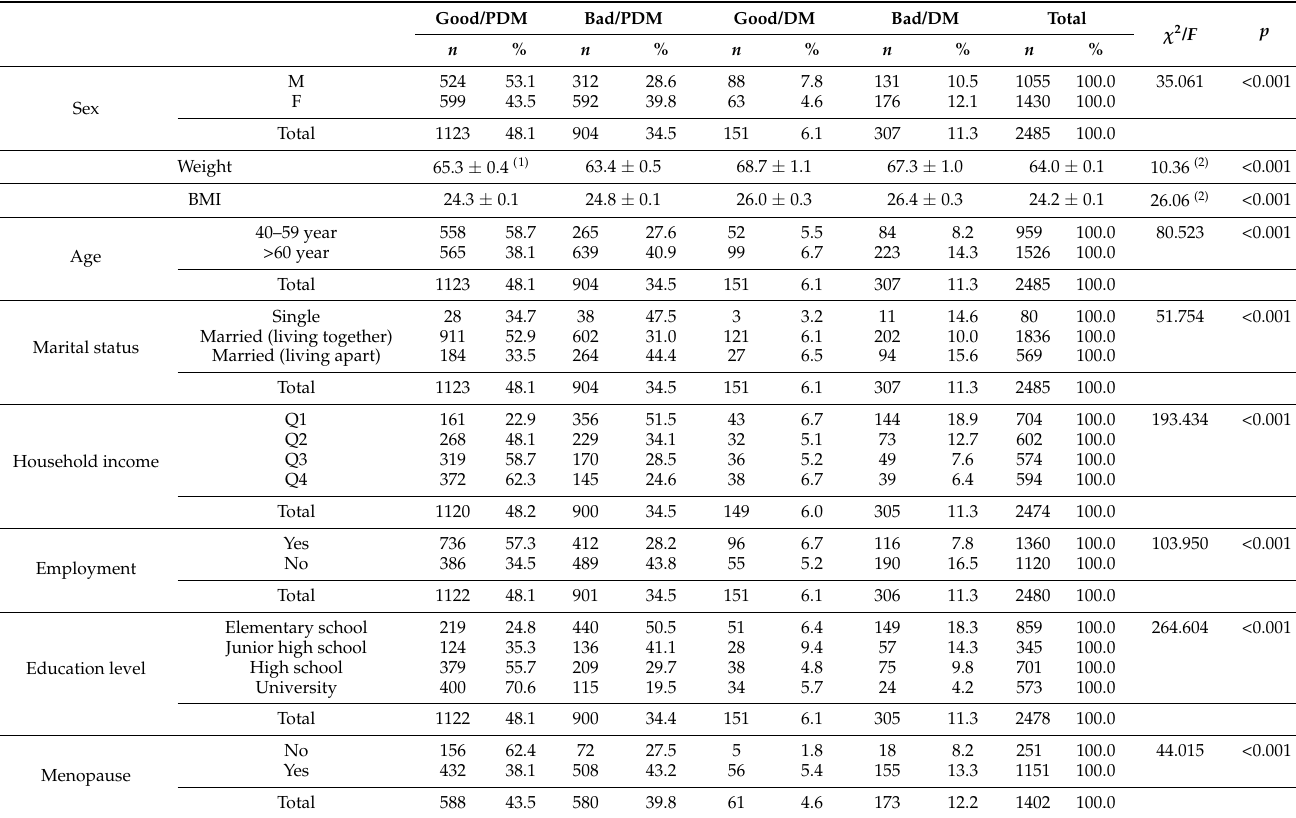
Table 1. Chracteristics of subjects.